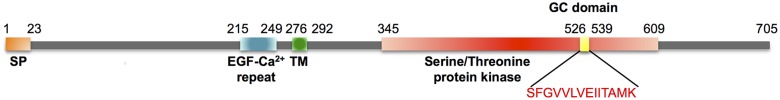
OsWAK25 has the domains characteristic of a WAK-RLK.Protein motifs and domains of OsWAK25 were identified using the Simple Modular Architecture Research Tool (SMART) database (http://smart.embl-heidelberg.de/) and NCBI-CDD (http://www.ncbi.nlm.nih.gov/Structure/cdd/wrpsb.cgi). The GC domain was identified manually. SP, signal peptide (orange); EGF-Ca2+ repeat (blue) TM, transmembrane region (green); serine-threonine kinase domain (red); GC, guanylyl cyclase domain (yellow).